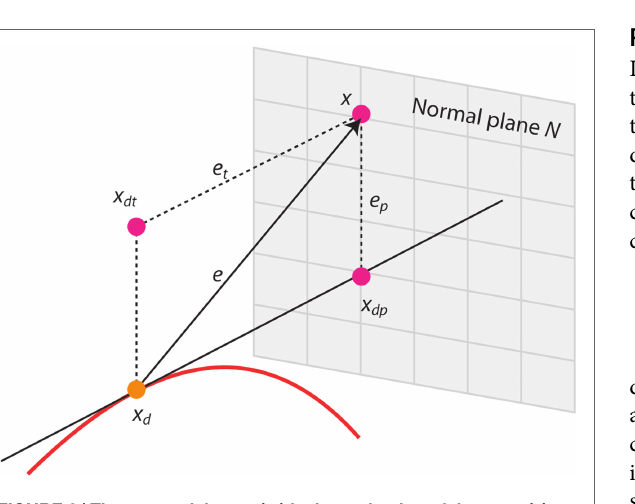
FIGURE 2 | Example of force field generated by: (A) the tangential haptic guidance controller at a desired position ( x d ) on the target trajectory, (B) the perpendicular error amplification controller with tubular transition to haptic guidance for large errors, and (C) the tubular mixed guidance controller .